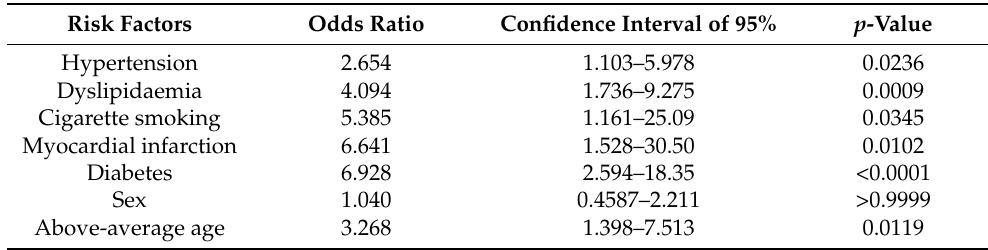
Table 10. Analysis of the correlations between the risk factors and worsening of stenosis in patients with previous ischemic stroke (worsened patients: 59; stable patients: 49; and total patients: 108). Risk Factors Odds Ratio Confidence Interval of 95% p -Value